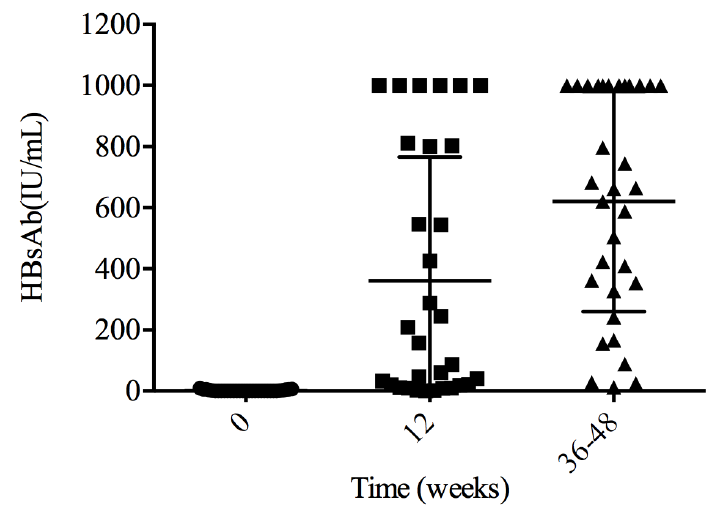
Figure 1. HBsAb levels after primary vaccination. All patients achieved a protective HBsAb titer between weeks 36 and 48.